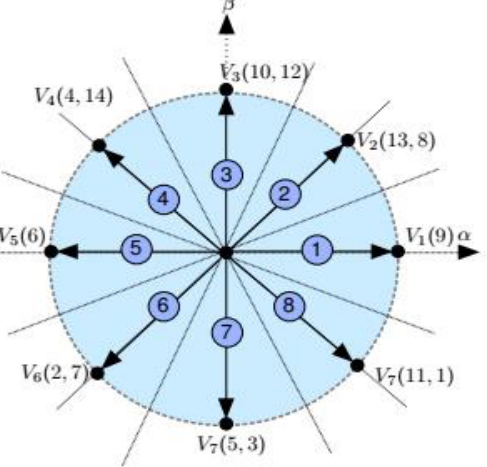
operation (see Table 2). Table 2. Dwell times during the fault. Dwell Time Figure 5. Representation of voltage vectors in the α – β and x – y spaces ( a ) in healthy condition ( b ) in faulty condition. Figure 5. Representation of voltage vectors in the α – β and x – y spaces (a) in healthy condition ( b ) in faulty condition . 408 Accordingly, the virtual voltages set described in Ref.[43] are no more valid and a 409